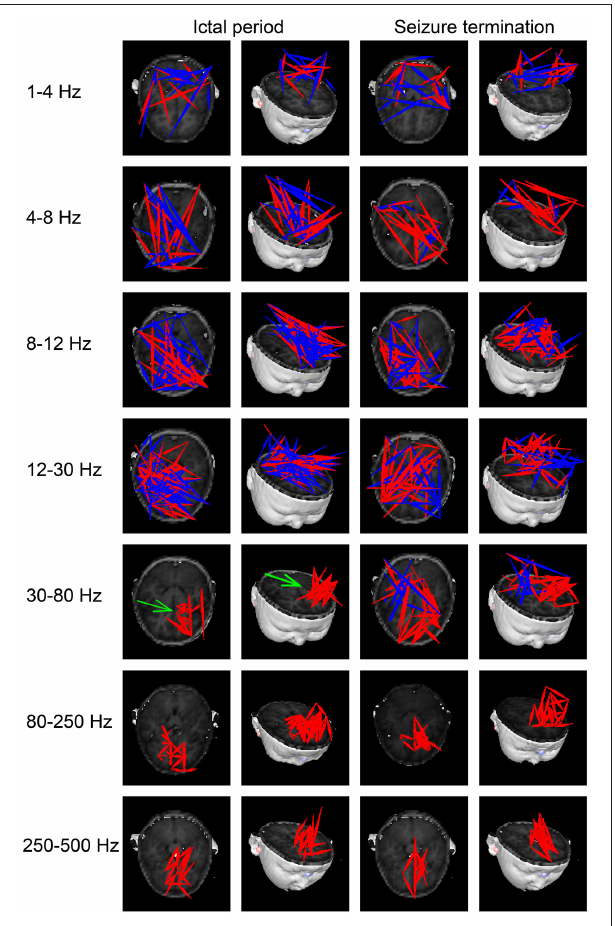
FIGURE 2 | Typical patterns of functional connectivity (FC) networks from childhood absence epilepsy (CAE) patients in seven frequency bands. Red indicates excitatory connections, and blue indicates inhibitory connections. The green arrow indicates significant differences in FC patterns between the two groups. The above results were significant ( p < 0.05) after false discovery rate (FDR) and Bonferroni